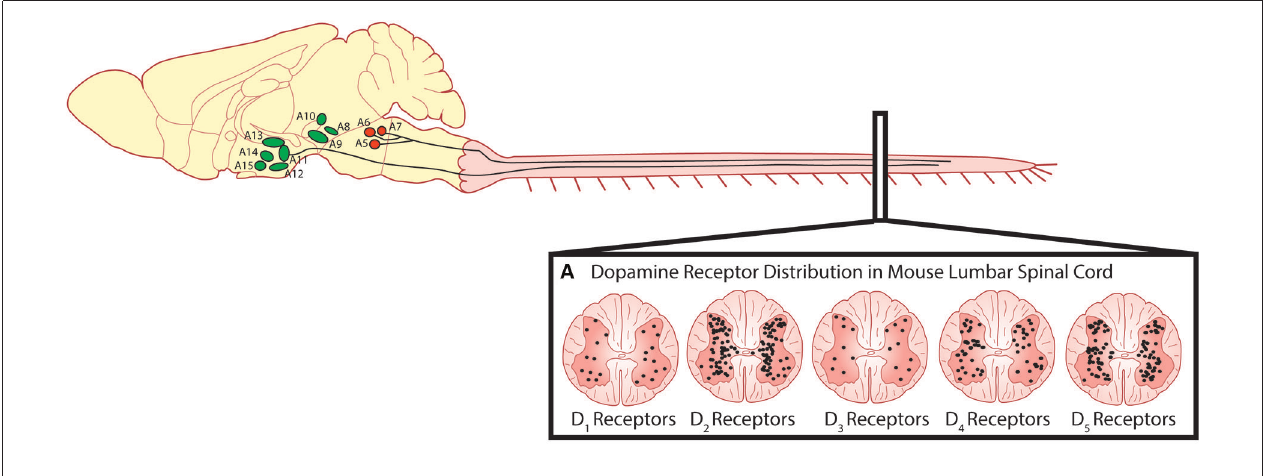
permission from Zhu et al., 2007). Descending noradrenergic fibres originating in the A5, A6 and A7 nuclei of the pons innervate the spinal cord. Schematic adapted with permission from Björklund and Dunnett